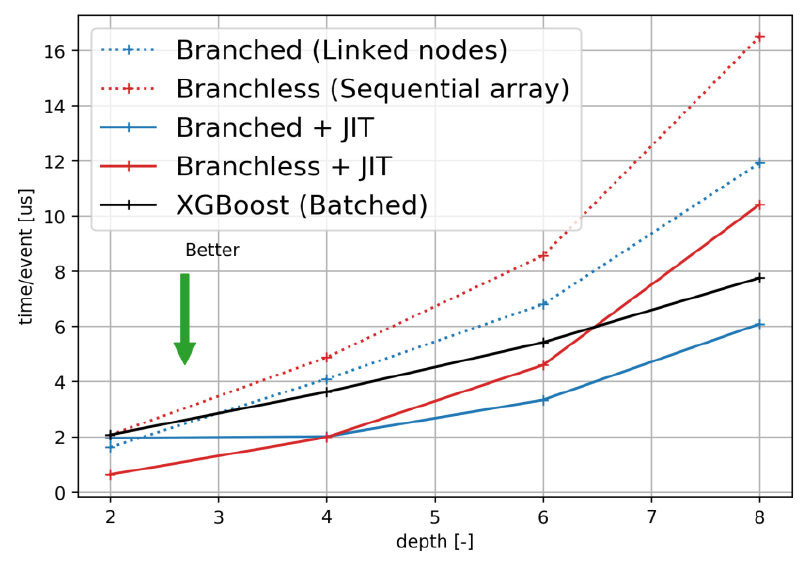
Fig. 4. Performance worsens for branchless implementation for greater depth of the tree, both for the jitted and non-jitted